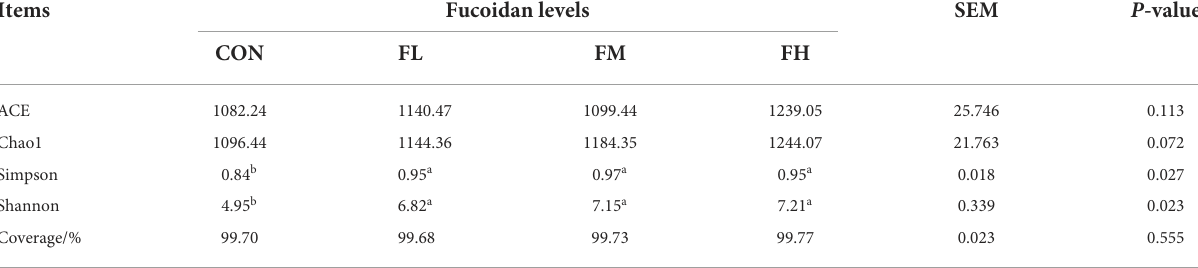
TABLE 2 The effects of fucoidan on the microbial alpha diversity index in the ceca of weaned lambs. Items